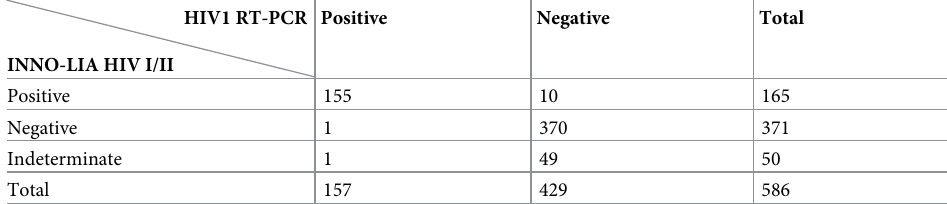
Table 4. Comparison between INNO-LIA ™ HIVI/II and